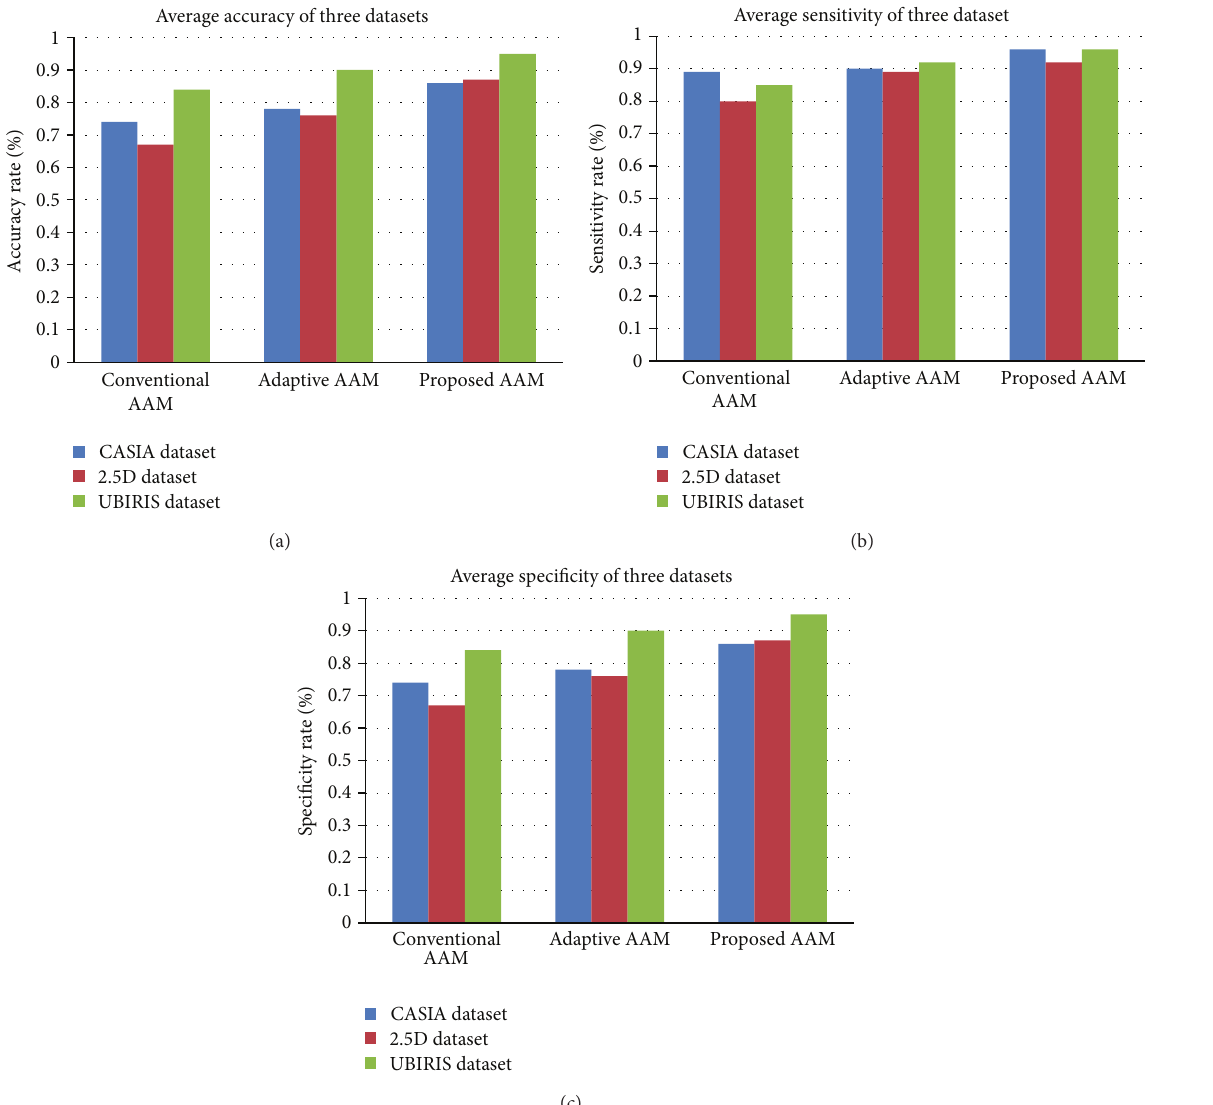
Figure 4: Average of ten cross validation results recognition performance for three datasets in terms of (a) accuracy, (b) sensitivity, and (c) specificity for conventional AAM, adaptive AAM, and the proposed